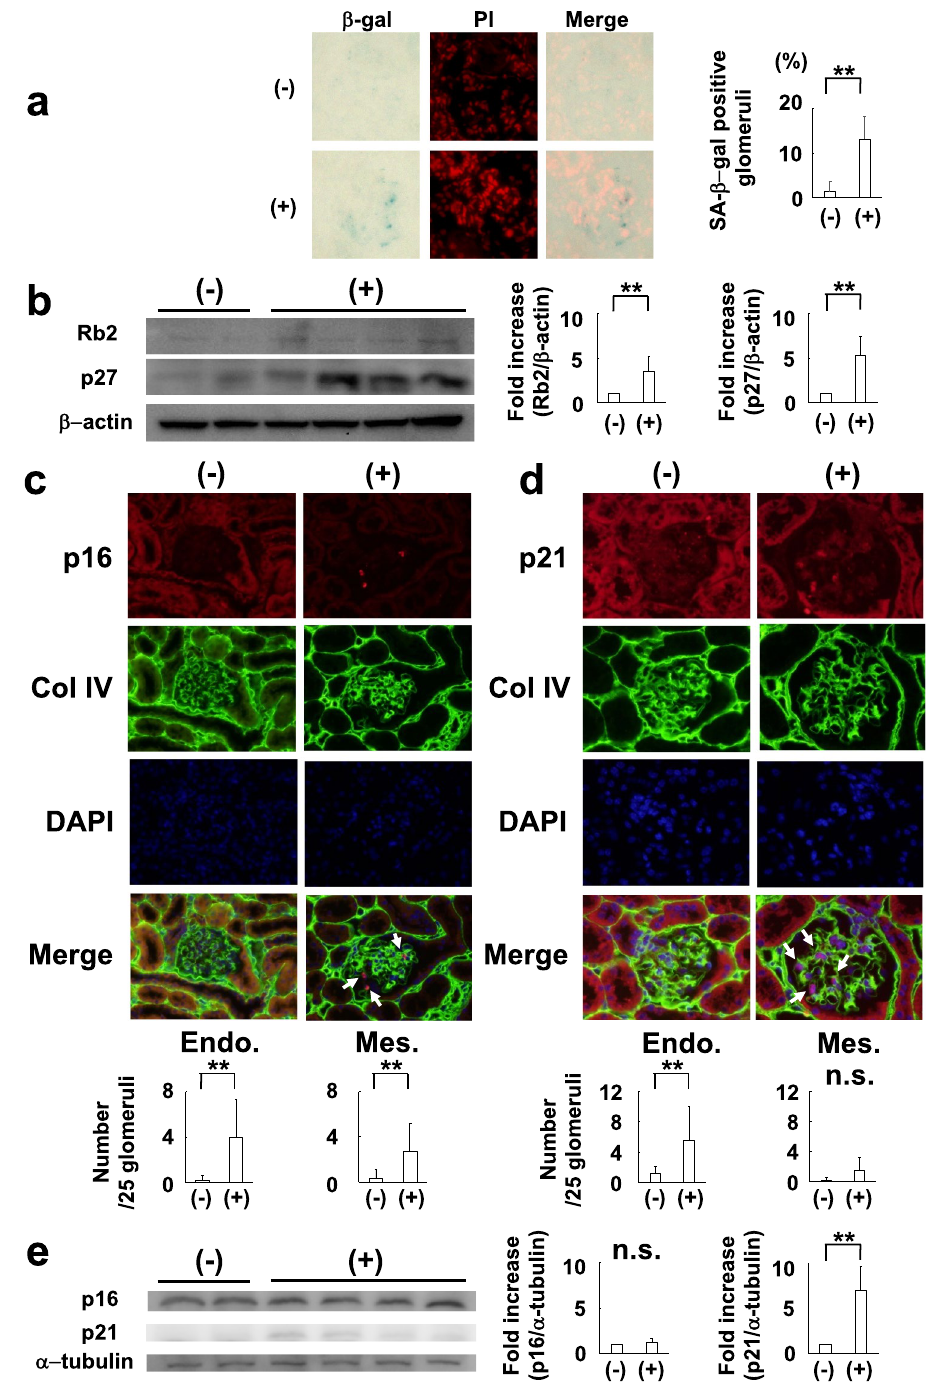
Figure 2. Detection of the markers for cellular senescence in podocyte-specific TGF-β1 overexpression mice. ( a ) Representative pictures of senescence-associated β-galactosidase staining. The nuclei were counterstained with propidium iodide. Senescence- associated β-galactosidase activity was significantly increased in PodCre(+) TGF mice. (N = 3 in control mice, N = 4 in PodCre(+) TGF mice). ** P < 0.05 (t-test). ( b ) Representative pictures of western blot analysis of Rb2 and p27 expression in glomeruli. PodCre(+) TGF mice had significant expression levels of Rb2 and p27. (N = 4 in control mice, N = 6 in PodCre(+) TGF mice). ** P < 0.05 (t-test). ( c ) Representative pictures of p16 immunohistochemistry. PodCre(+) TGF mice had p16 expression mainly in endothelial cells. PodCre(+) TGF mice showed a significant increase in p16 immunostained nuclei in endothelial and mesangial cells. (N = 6 in control mice, N = 8 in PodCre(+) TGF mice). ** P < 0.05 (t-test). ( d ) Representative pictures of p21 immunohistochemistry. PodCre(+) TGF mice had p21 expression mainly in endothelial cells. PodCre(+) TGF mice showed a significant increase in p21 immunostained nuclei in endothelial cells. (N = 6 in control mice, N = 8 in PodCre(+) TGF mice). ** P < 0.05 (t-test). ( e ) Representative pictures of western blot analysis of p16 and p21 expression in glomeruli. PodCre(+) TGF mice had a significant expression of p21, but not that of p16. (N = 4 in control mice, N = 6 in PodCre(+) TGF mice). ** P < 0.05 (t-test). (−): control mice. (+): Podocyte-specific TGF-β1 overexpression mice (PodCre(+) TGF mice). PI: Propidium iodide. SA-β-gal: Senescence-associated β-galactosidase. Col IV: Collagen IV. Endo.: Endothelial cell. Mes.: Mesangial cell. n.s.: not